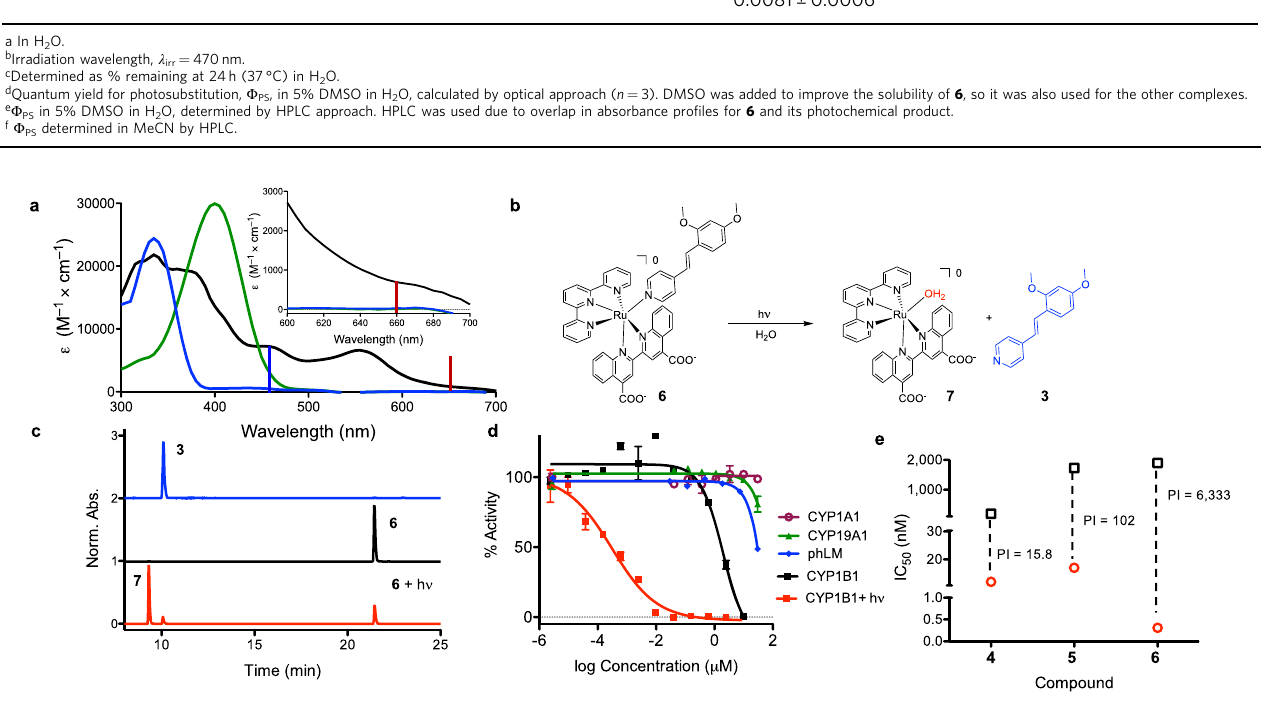
Fig. 4 Photocontrol of a Ru(II) complex containing a CYP1B1 inhibitor. a Absorption spectra of 6 (black, solid line) in phosphate buffered saline (PBS), 3 in MeCN (blue, solid line), and 3 in MeCN following protonation with 1% formic acid (green, solid line). The excitation wavelengths for the blue and red LEDs are indicated with vertical bars. Inset shows an expansion of the 600 – 700 nm region. b Photoejection scheme for 6 in water. c HPLC analysis showing the chromatograms for 3 , 6 , and 6 following irradiation with 660 nm light (58.7 J/cm 2 ). The formation of complex 7 and inhibitor 3 were veri fi ed by UV/Vis (Supplementary Fig. 11). The protonated form of 3 was observed due to the presence of acid in the HPLC mobile phase. Detection wavelength = 280 nm. d Dose – responses for 6 for enzyme inhibition in the dark with CYP1A1, 19A1, and pooled human liver microsomes (phLM), CYP1B1, and with 1B1 following irradiation with 660 nm light (58.7 J/cm 2 ) ( n = 3; the error bars correspond to the standard deviation of the three replicates). e Comparison of potency and PI values (the ratio of the IC 50 for enzyme inhibition in the dark vs. light) for Ru(II) complexes 4 – 6 (IC 50 in the dark (black squares) and activated with 660 nm light (red circles)). This data demonstrates a range of 10 3 due to improvement in both the inhibitor, with a shift to lower IC 50 values, and Ru(II) scaffold, with the increase in the IC 50 in the